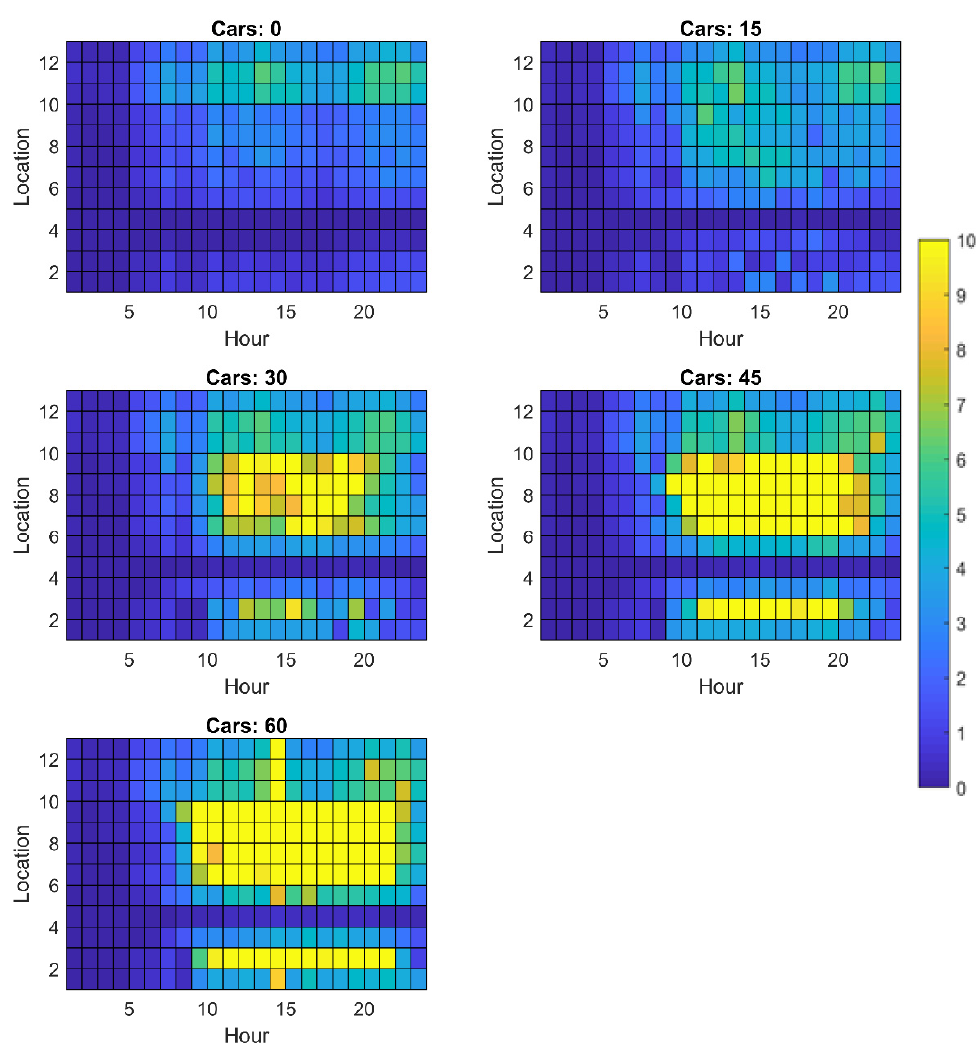
Figure A6. Maximum voltage drops (percentage) observed in network 3 with distributed generation OFF.